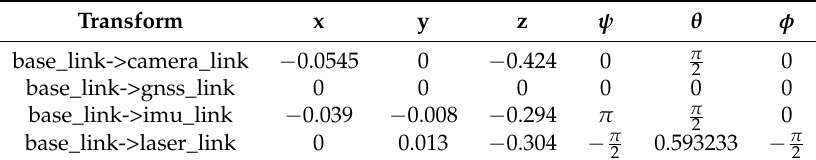
Table A2. Sensor frame transforms defined in ROS for the UAV.